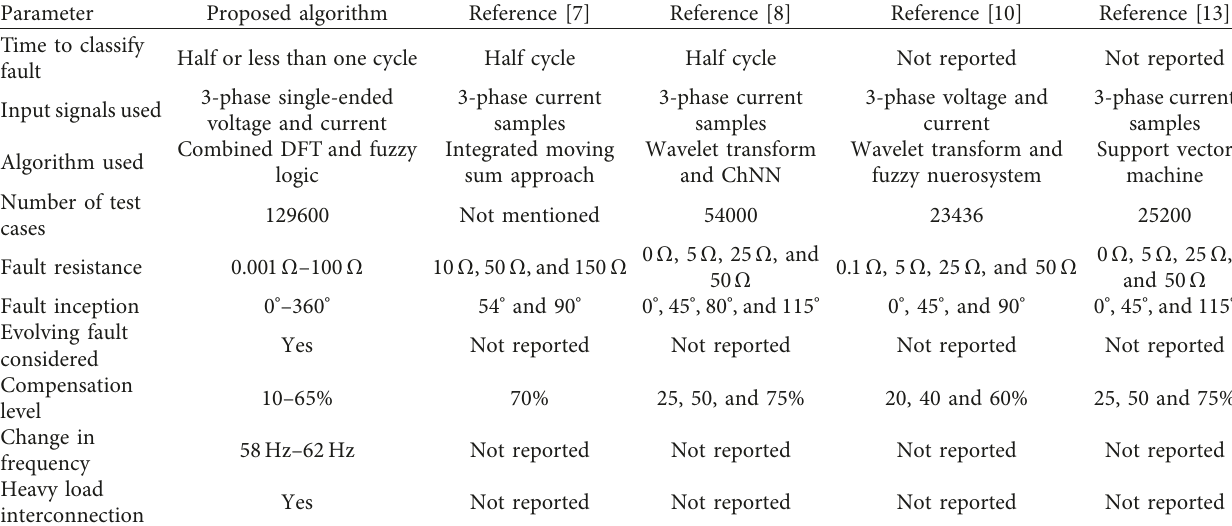
Table 14: Comparisons with other